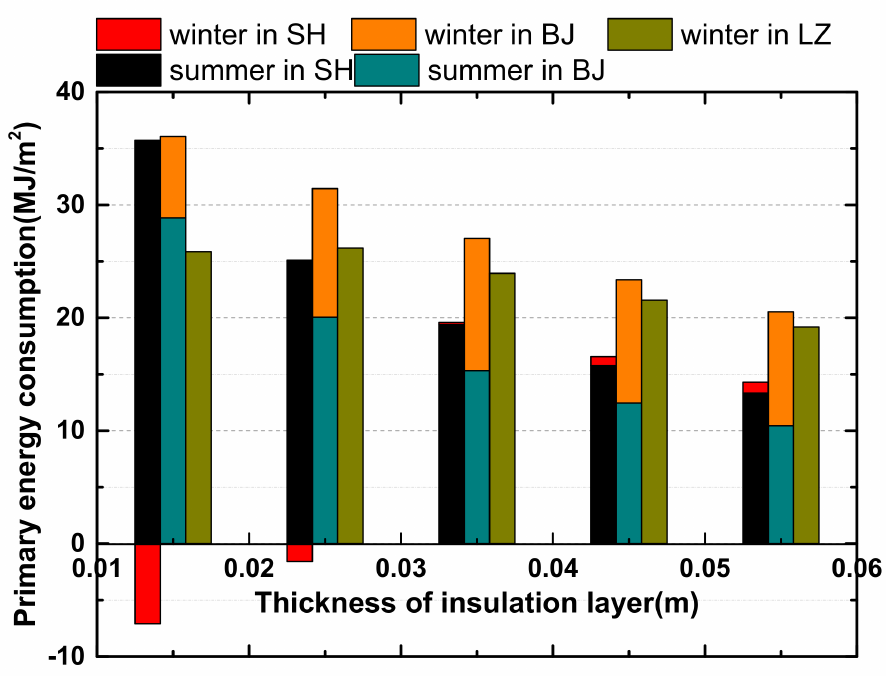
Figure 14. Variation of primary energy consumption with insulation layer